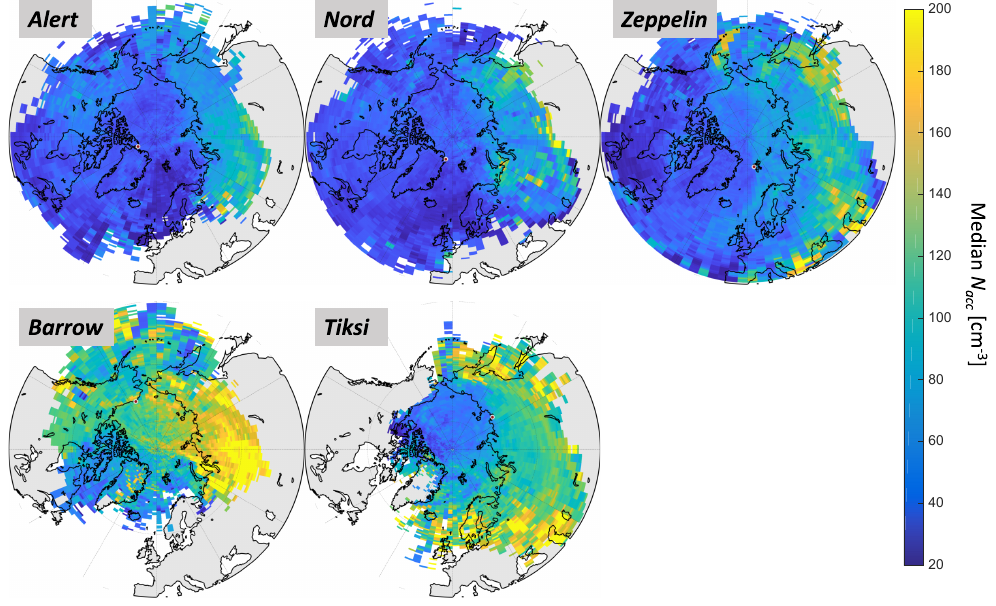
Figure 8. Maps of median concentrations of accumulation-mode particles. Every 240h long back-trajectory is associated with the concen- tration that was measured at the site at the air mass arrival time – according to the trajectory analysis. The colour of each grid cell denotes the median concentration related to all trajectories crossing that cell. Each subplot represents a different site, whose location is indicated in red. All available data were included for each of the sites, but only grid cells with at least 10 trajectory passes are presented for statistical